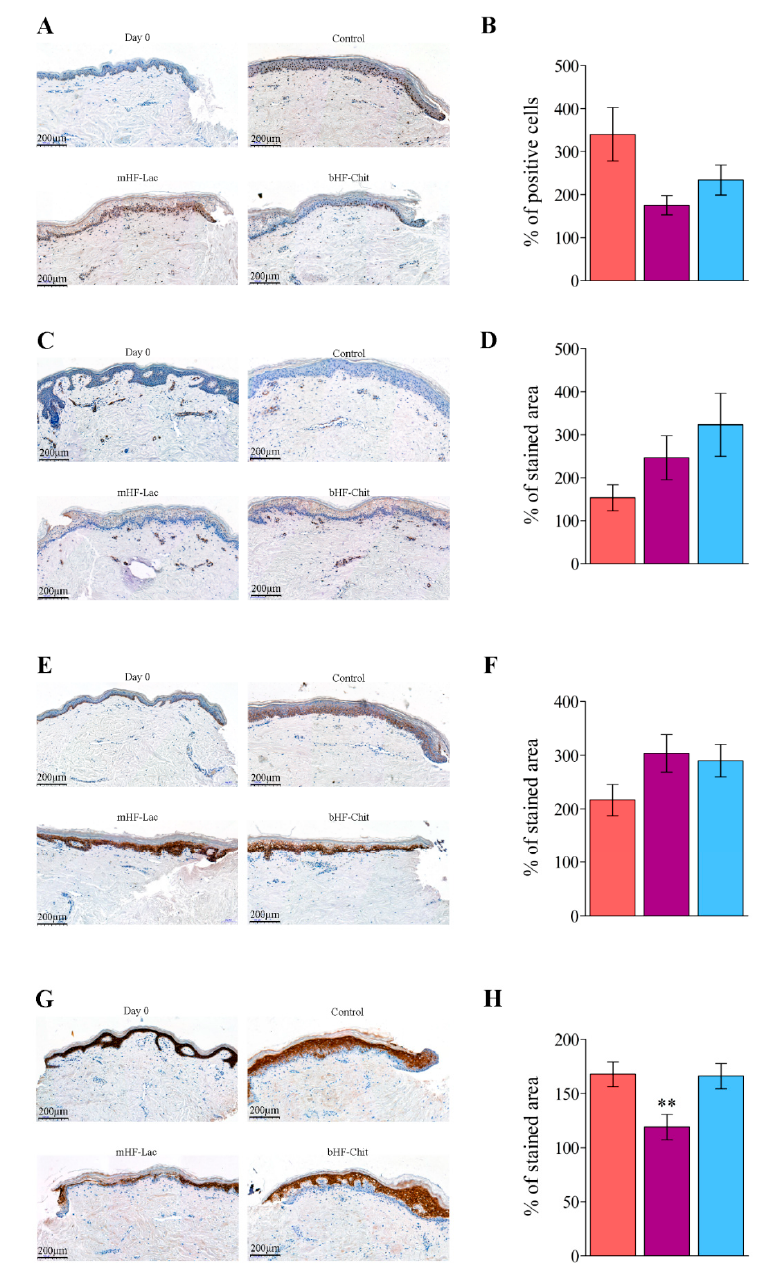
Figure 6. ( A ) Representative images of tissue sections stained against PCNA. ( B ) Representation of PCNA positive cells percentage regarding to baseline. ( C ) Representative images of tissue sections stained against α -SMA. ( D ) Representation of quantitative analysis of α -smooth muscle actin ( α